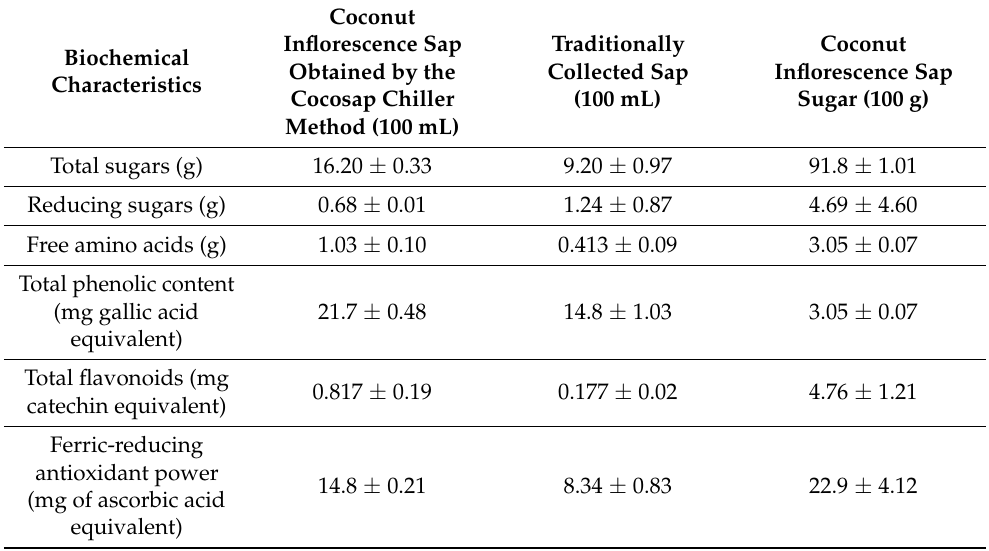
Table 6. Coconut inflorescence sap obtained with a Cocosap chiller (conventional method) and coconut sugar were studied for their biochemical components and ferric-reducing antioxidant power